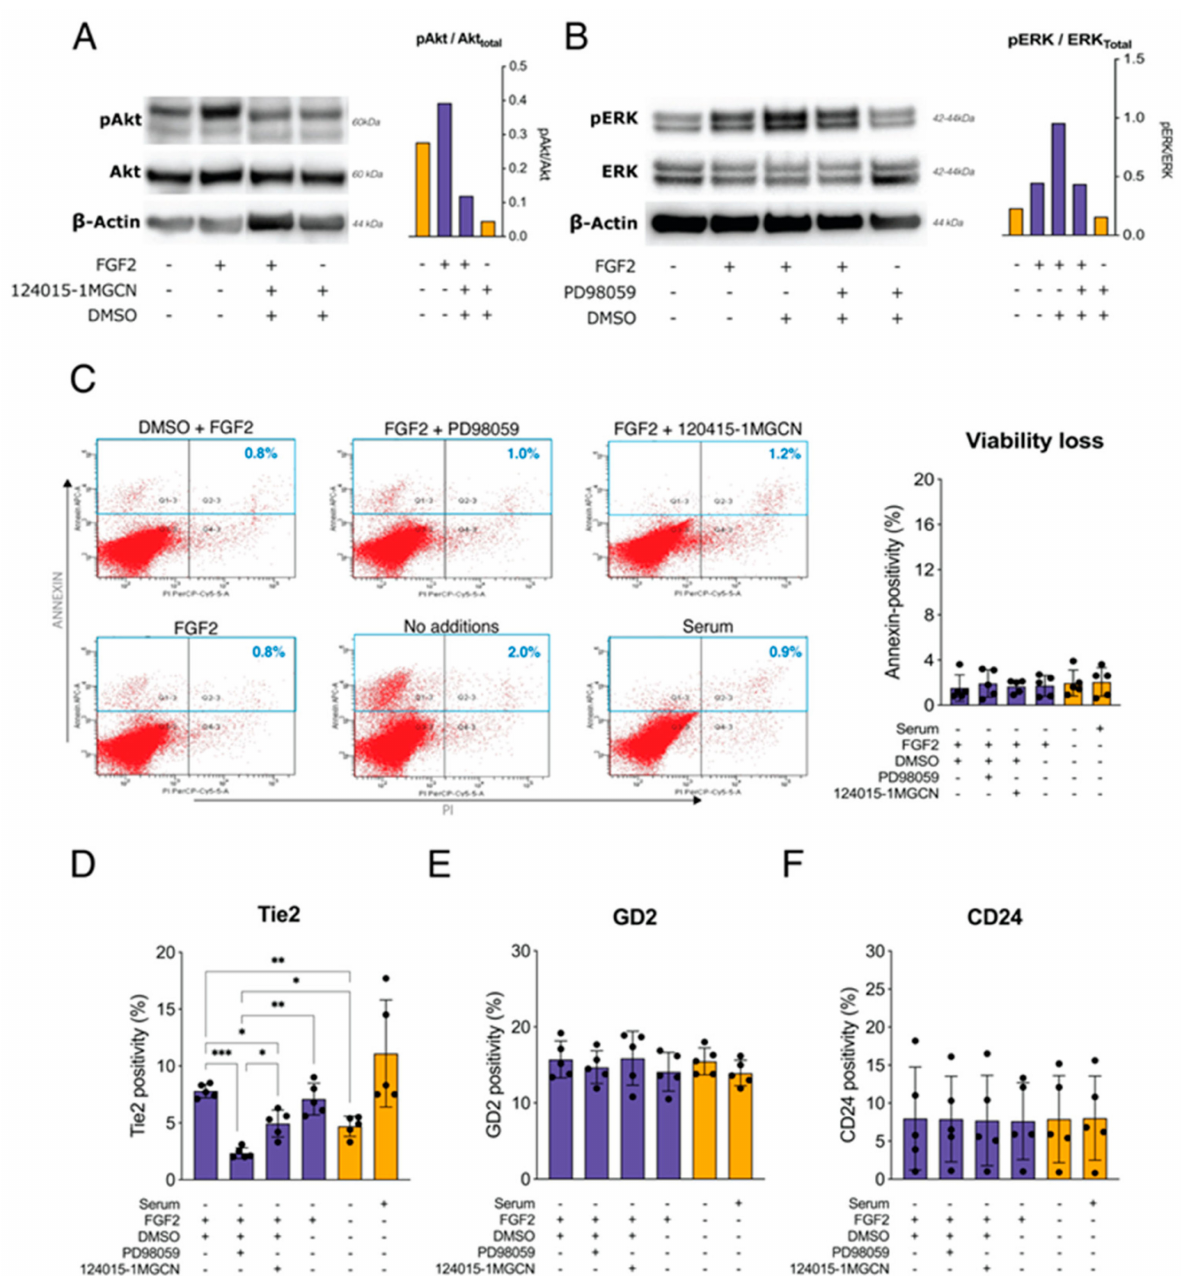
Figure 3. Effect of Akt and MEK inhibition on Tie2 maintenance. ( A ) Western blot to determine the reduced phosphorylation of Akt following FGF2 stimulation (24 h) when subjected to Akt inhibitor 124015-1MGCN ( n = 1). ( B ) Western blot showing the ability of PD98059, a MEK inhibitor, to interfere with FGF2 induced ERK phosphorylation ( n = 1). ( C ) Flow cytometry ( n = 5) analysis based on propidium iodide (PI) and annexin based gaiting to exclude negative effects on viability by 124015-1MGCN and PD98059. Flow cytometry analysis ( n = 5) determining the fraction of ( D ) Tie2, ( E ) GD2, and ( F ) CD24 expressing NP cells following 24 h of specified culture. Note DMSO was added as a control to compensate for effect potentially caused by the DMSO included in PD98059 and 124015-1MGCN storage solutions. All values presented as means, and error bars represent standard deviation. * p < 0.05, ** p < 0.01, and *** p < 0.005. Purple bars: FGF2 included conditions, Orange bars: FGF2 non-included